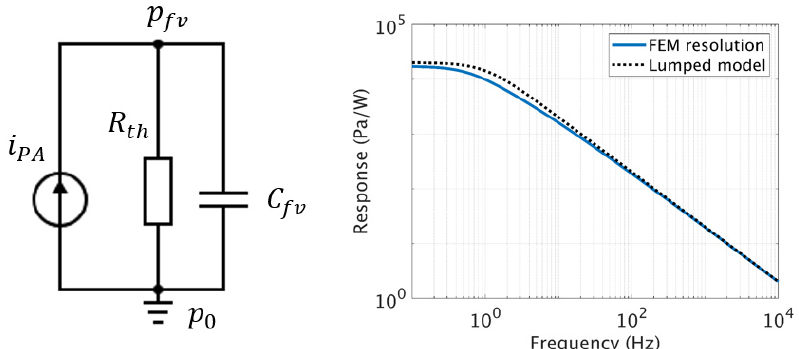
Figure 5. On the left, equivalent electrical circuit responsible for the pressure generation in the closed front volume p fv . On the right, transfer function of the circuit (generated pressure per deposited power) and comparison with the FEM simulation using the thermoacoustic